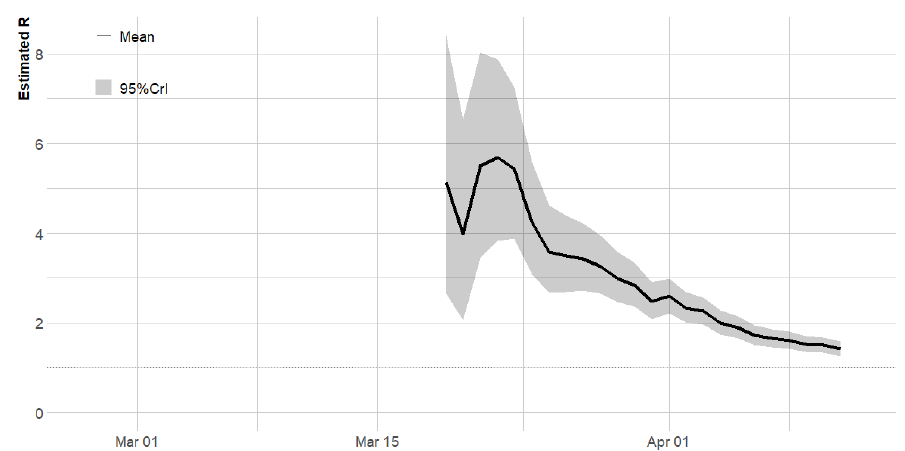
Figure 5. Time-varying reproduction number of COVID-19 in Nigeria based on a three-week sliding window [10,14,15] that accounted for imported and local transmission. The black line represents the posterior median, and the grey shaded region represents the 95% credible interval (CL).